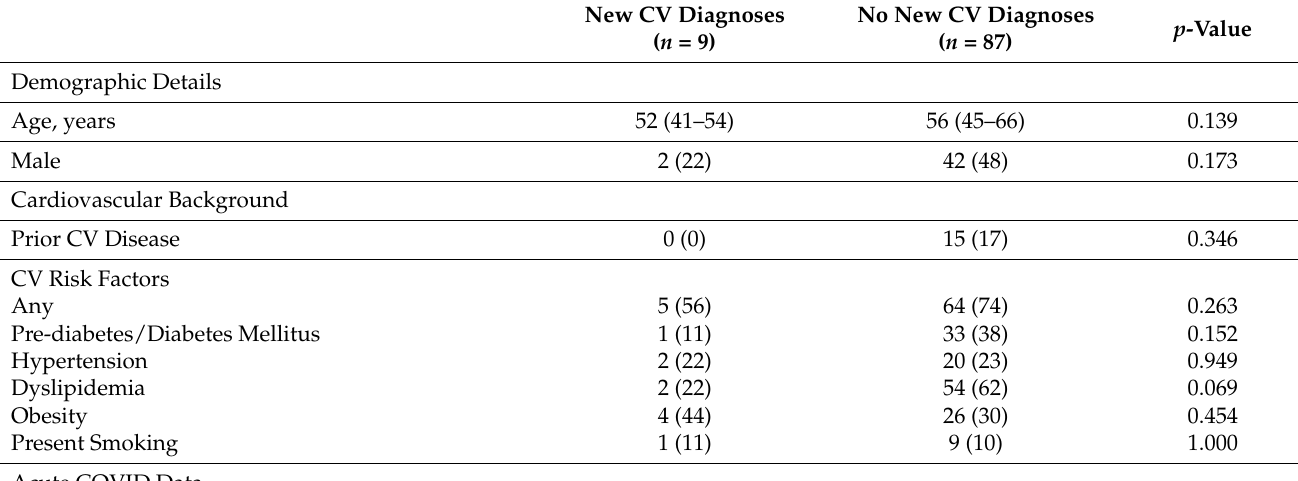
Figure 4. One-year trends of long-COVID symptomatology believed to be cardiovascular. At 1-year follow-up, most patients felt their symptoms to improve compared to the initial visit. No major difference was noted between those who were diagnosed with new, potentially COVID-related car- diovascular conditions and those who were not. COVID = coronavirus disease; CV = cardiovascular. Table 3. Baseline patient characteristics according to the presence of a new, presumably COVID- related cardiovascular